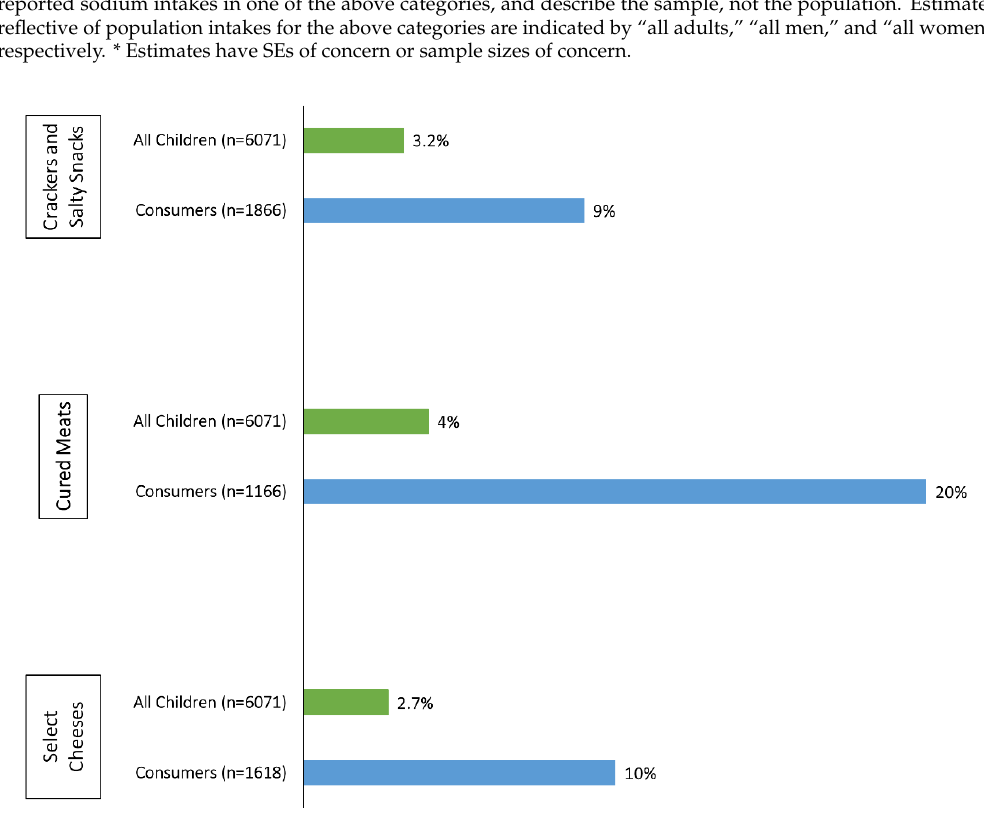
Figure1. Percentage-wisecontributionsfromselectedfoodgroupsontotalsodiumintake(inmilligrams) Figure 1. Percentage-wise contributions from selected food groups on total sodium intake (in in the diets of U.S. children (aged 1–18 years), National Health and Nutrition Examination Survey milligrams) in the diets of U.S. children (aged 1 – 18 years), National Health and Nutrition Examination 2013–2016. Based on FDA-NIH Biomarker Working Group [2] and U.S. National Academies of Sciences